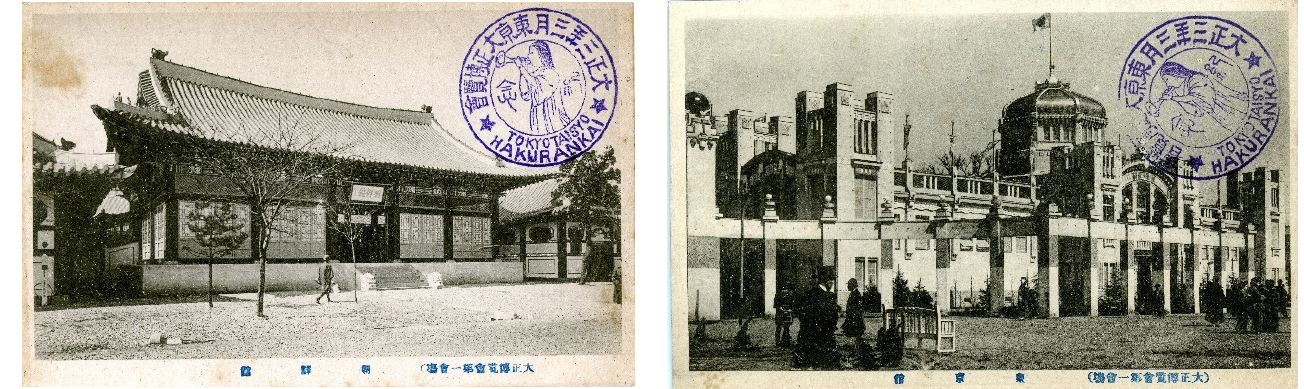
Figure 24. ( Left ) Korea Pavilion at the 1914 Tokyo Taisho Expo. ( Right ) Tokyo Pavilion at the 1914 Tokyo Taisho Expo (Source: Database of the Pre-1945 East Asian Postcards) [30].